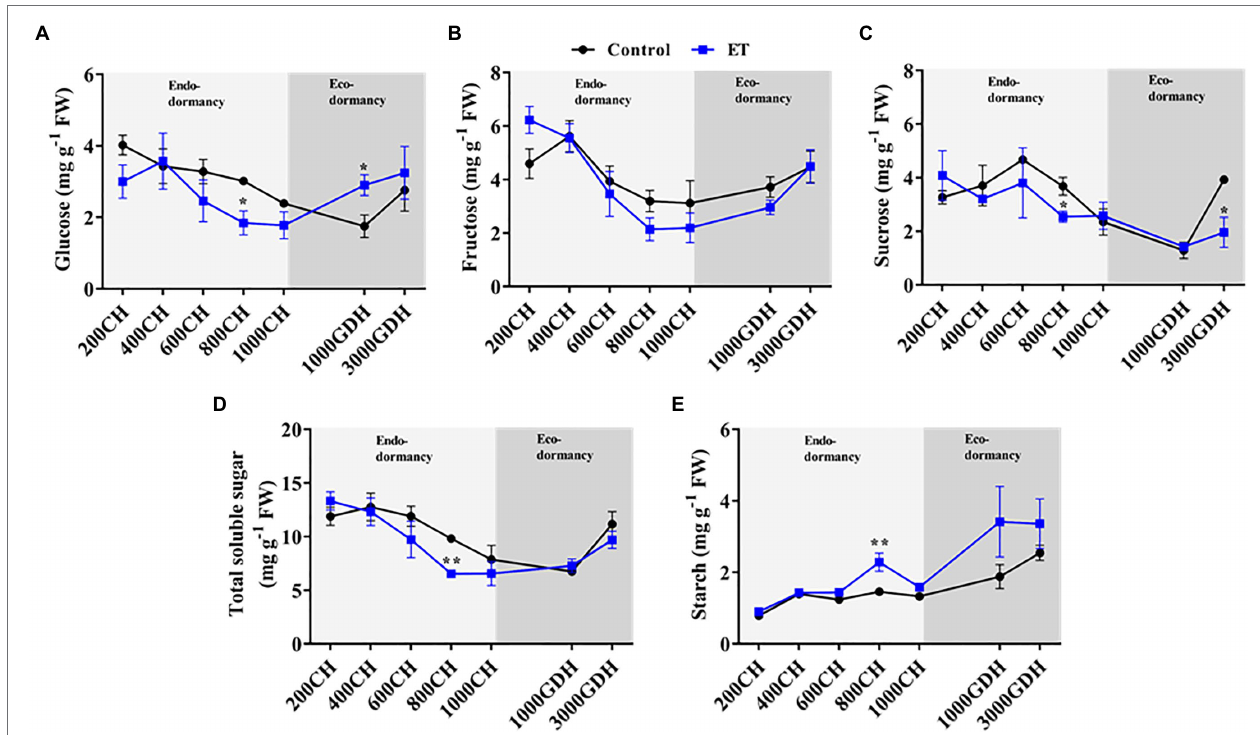
FIGURE 6 | Effects of the ethephon (ET) on the temporal changes of the soluble sugar and starch accumulation during the dormancy in peach “Red haven” floral buds. Glucose (A) , fructose (B) , sucrose (C) , total soluble sugar (D) , and starch (E) . Data represent the mean ± SEM for n = 3. Asterisks indicate significant differences between the control and ET-treated plant buds at different chilling hours (CH) and GDH; ∗ p < 0.05; and ∗∗ p <